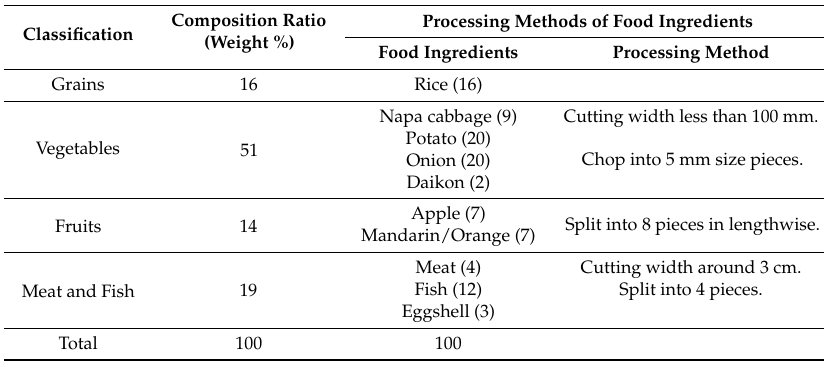
Table 1. The standard sample of food